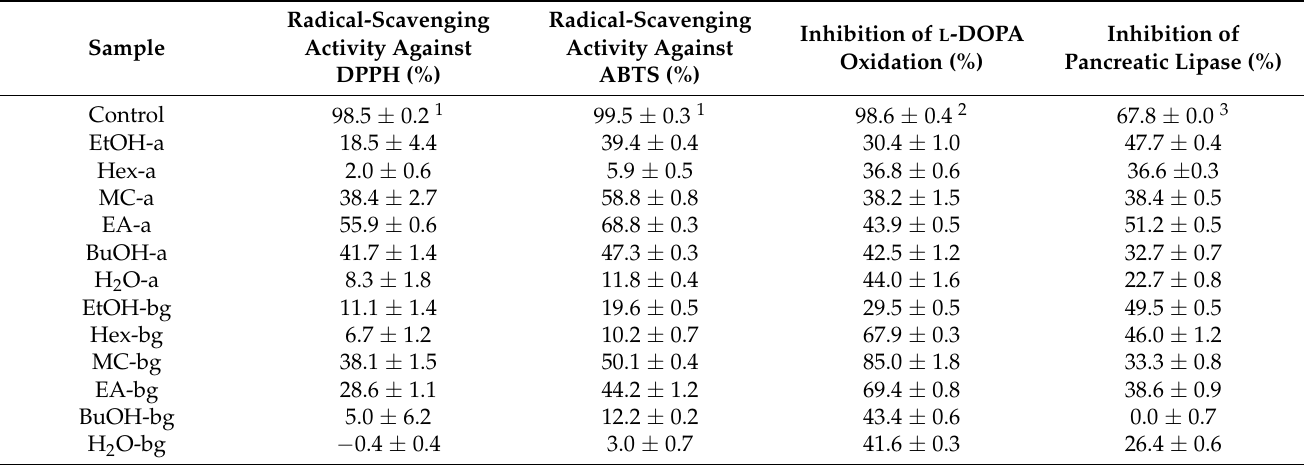
Table 1. Bioactivities of the extracts and fractions of Spartina anglica at 100 µ